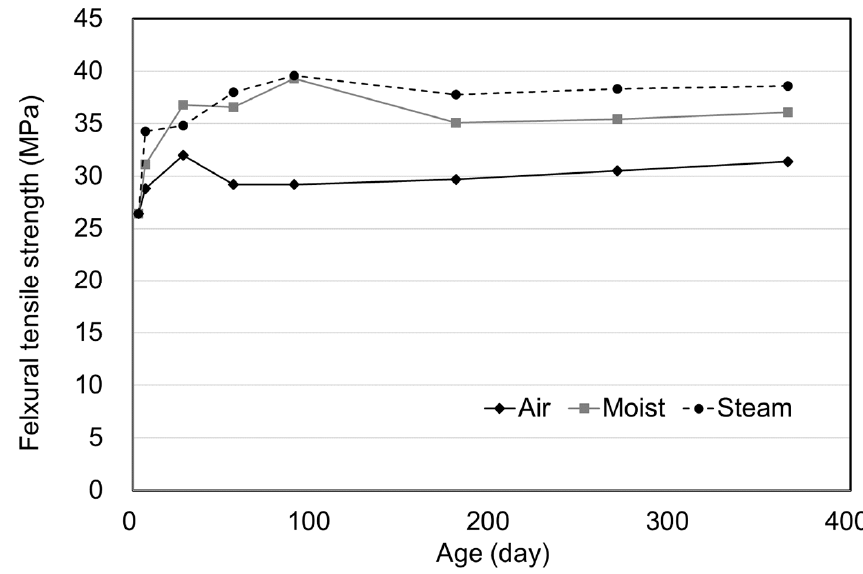
Figure 16. Experiment results for flexural tensile strength.